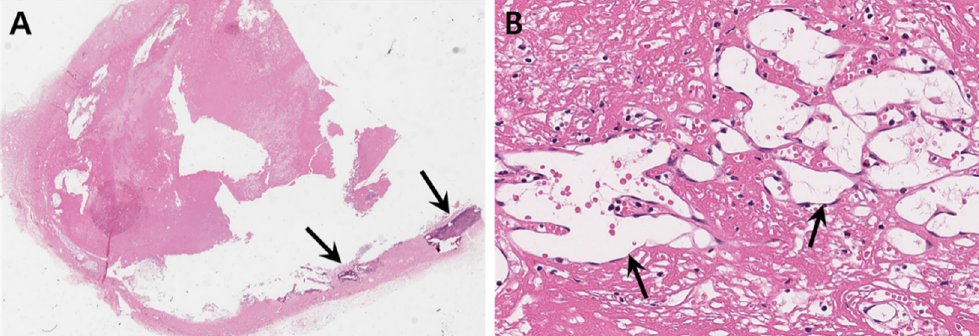
Figure 5. Histopathologic images. ( A ) On low-power field (×10), the lesion reveals a cystically dilated cavitary lesion filled with necrotic fibrinoid material. Hyalinized cystic wall contains dystrophic calcifications (arrows). ( B ) On higher magnification (×200), there are multifocal fibrin thrombi with evidence of recanalization (arrows) and lymphocytic infiltration.